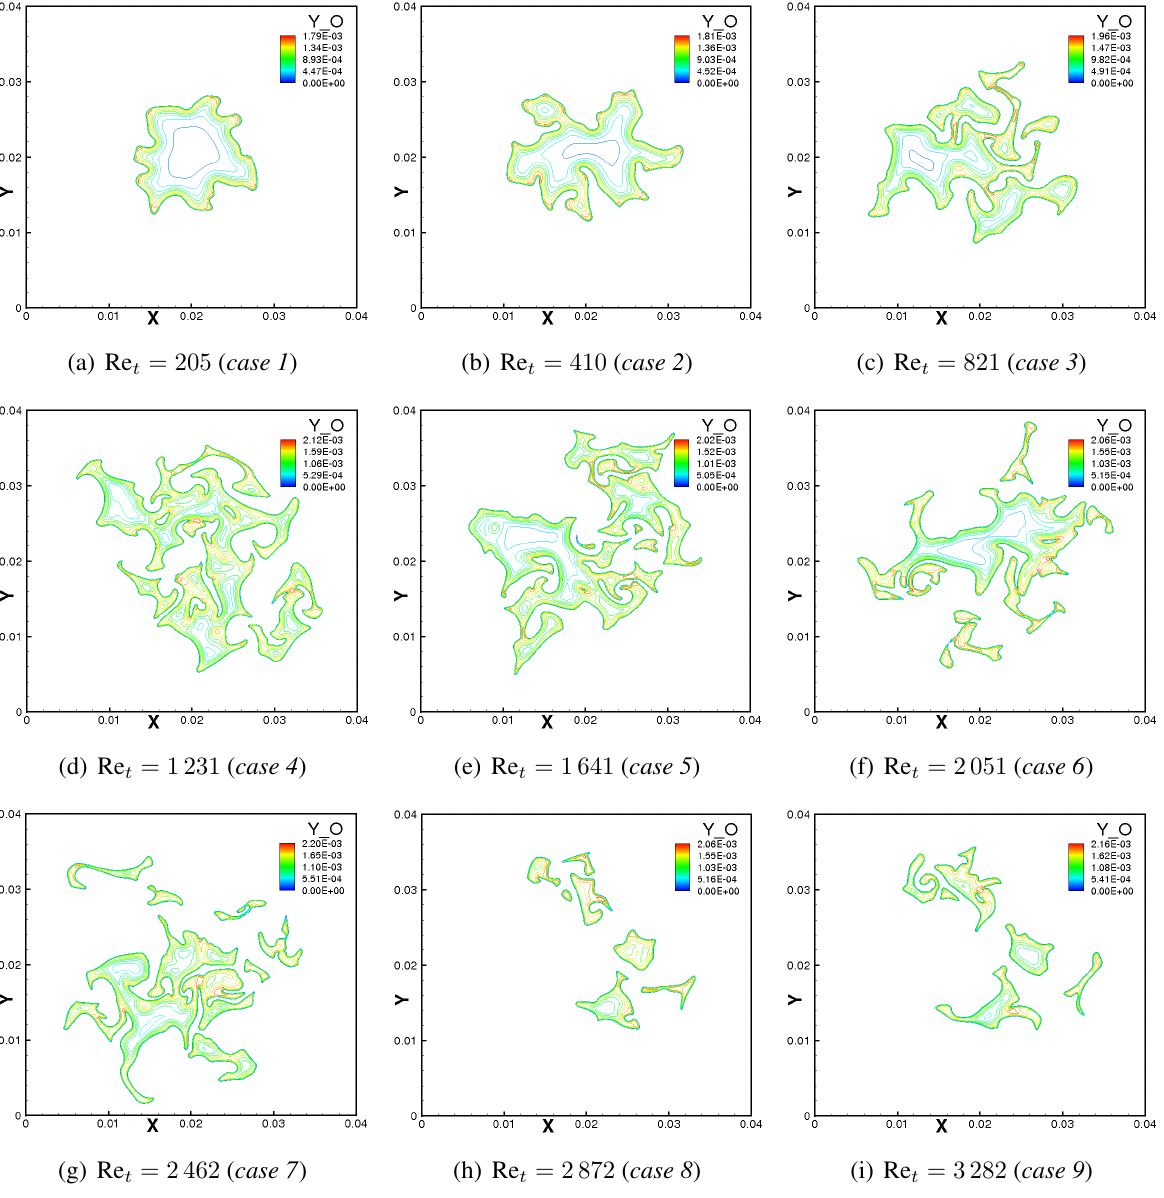
Figure 4. Instantaneous iso-surface of the mass fraction of O for different integral Reynolds number Re at the same mixture equivalence ratio Φ = 0 . 9 and same time t = 1 . 3 τ t